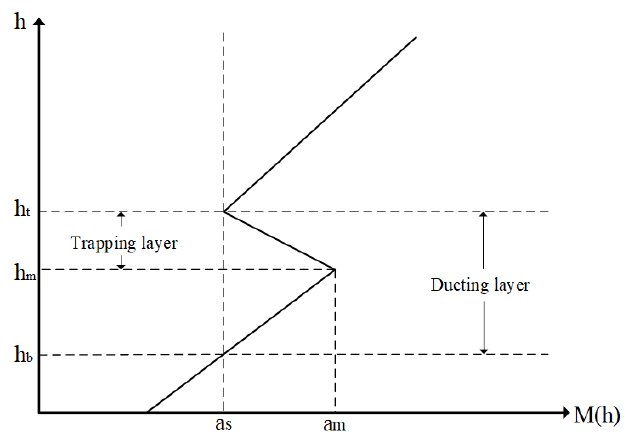
Figure 1. Schematic illustration of trapping layer and